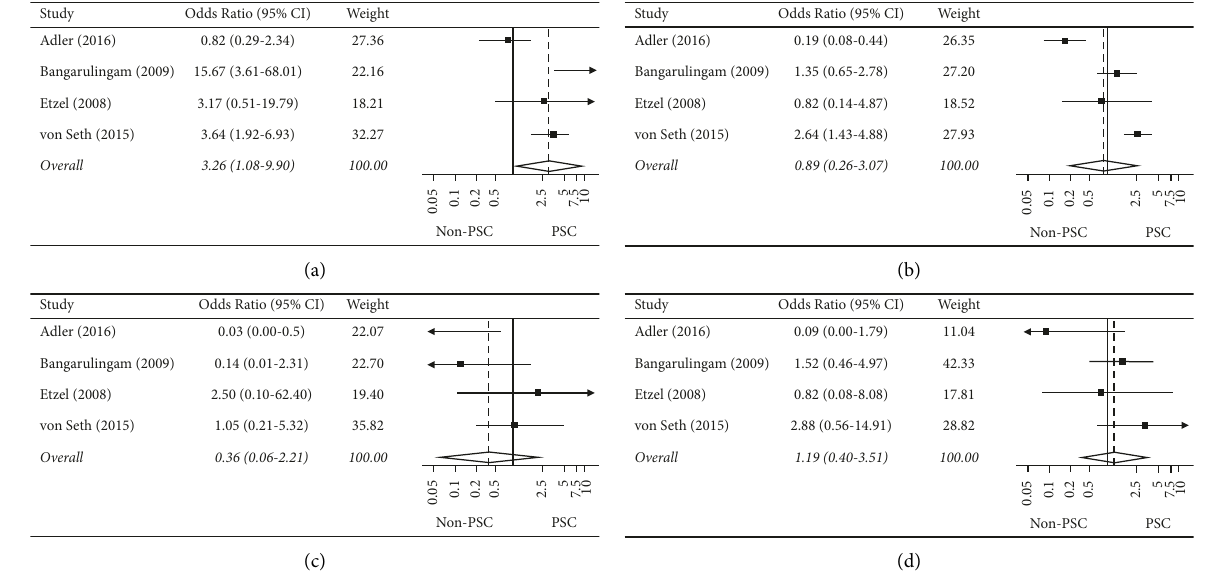
Figure 2: (a) Forest plot of the individual and combined odds of cholangitis, (b) forest plot of the individual and combined odds of pancreatitis, (c) forest plot of the individual and combined odds of bleeding, and (d) forest plot of the individual and combined odds of